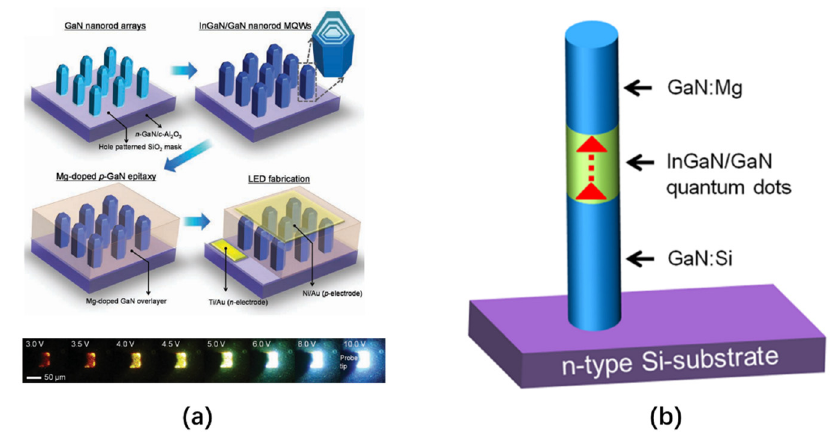
Figure 19. ( a ) Shell/core nanowire LED structure and EL images driven by different external voltages. Reproduced from [116], with permission from John Wiley and Sons, 2011; ( b ) InGaN/GaN dot-in-a-wire LED structure. Reproduced from [117], with permission from Institute of Physics, 2011. All rights reserved.